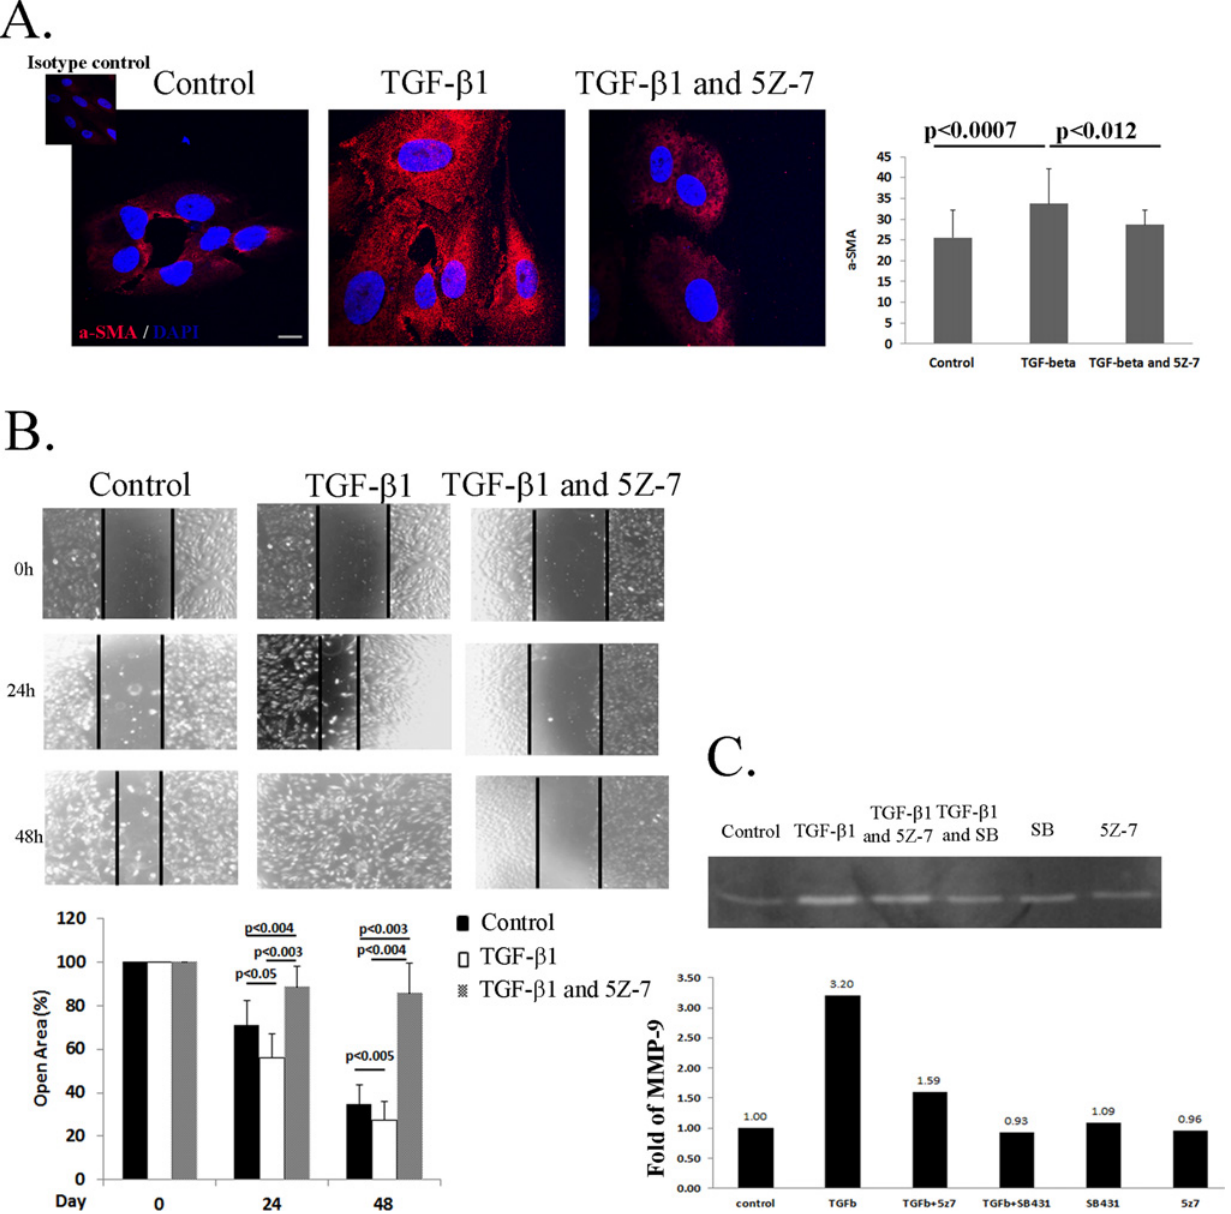
Fig 2. TAK1 regulates RPE cells EMT phenotype upon TGF- β stimulation. A: RPE cells were serum-starved for 16 hours, pretreated with 5Z- 7-oxozeaenol (1 μ M) or left untreated for 1 hour. The cells were then treated with TGF- β 1 (2.5ng/ml) as described in Materials and Methods for 24h and immunostained with α -SMA antibodies (red) and DAPI (blue). Representative photographs of three independent experiments. The histogram represent quantification of pixel intensity B: RPE cells were serum-starved for 16 hours, then treated with mitomycin C (10ng/ml) for 3h. Thereafter, pretreated with 5Z- 7-oxozeaenol (1 μ M) or Dimethyl sulfoxide (DMSO) for 1 hour. Following this process a scratch was performed in the cell monolayer and the serum free medium was supplemented with TGF- β 1 (2.5ng/ml) or left unsupplemented. Scratches were photo-documented at the indicated times (top panel) and their width was measured using Image-J software. The histogram (bottom panel) demonstrates the percentage of remaining gap at each time point, relative to initial gap width, based on three independent experiments. Bars are Mean ± SD. C: RPE cells were serum-starved for 16 hours then pretreated with 5Z- 7-oxozeaenol (1 μ M) or SB431542 (10 μ M), or DMSO for 1 hour. Finally, the medium was replaced with serum free medium with or without TGF- β 1 (2.5ng/ml) and supernatants from the different treatments were collected after 24 hours. Total MMP-9 activities were processed by gelatin zymography (top panel) and the band intensity values were calculated by Quantity One 1-D analysis software. Histogram demonstrating secretion levels of MMP-9 in the different treatments (bottom panel). Statistics were computed using student t-test (Two tailed distribution equal variance). Data is expressed as the Mean ± SD.